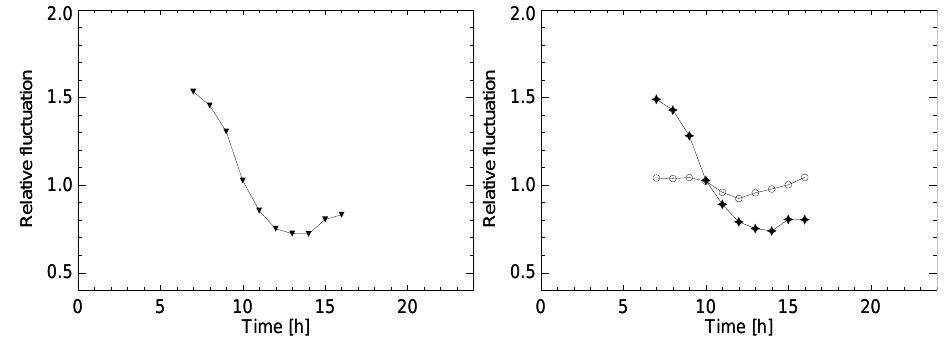
Fig. 10. Left: relative diurnal cycle of LWP of all clouds in the low cloud deck off the coast of Namibia and Angola as seen from SEVIRI in October 2009. Right: relative diurnal cycle split into the intrinsic variability of LWP (black stars) and the variability caused by cloud fraction fluctuation.